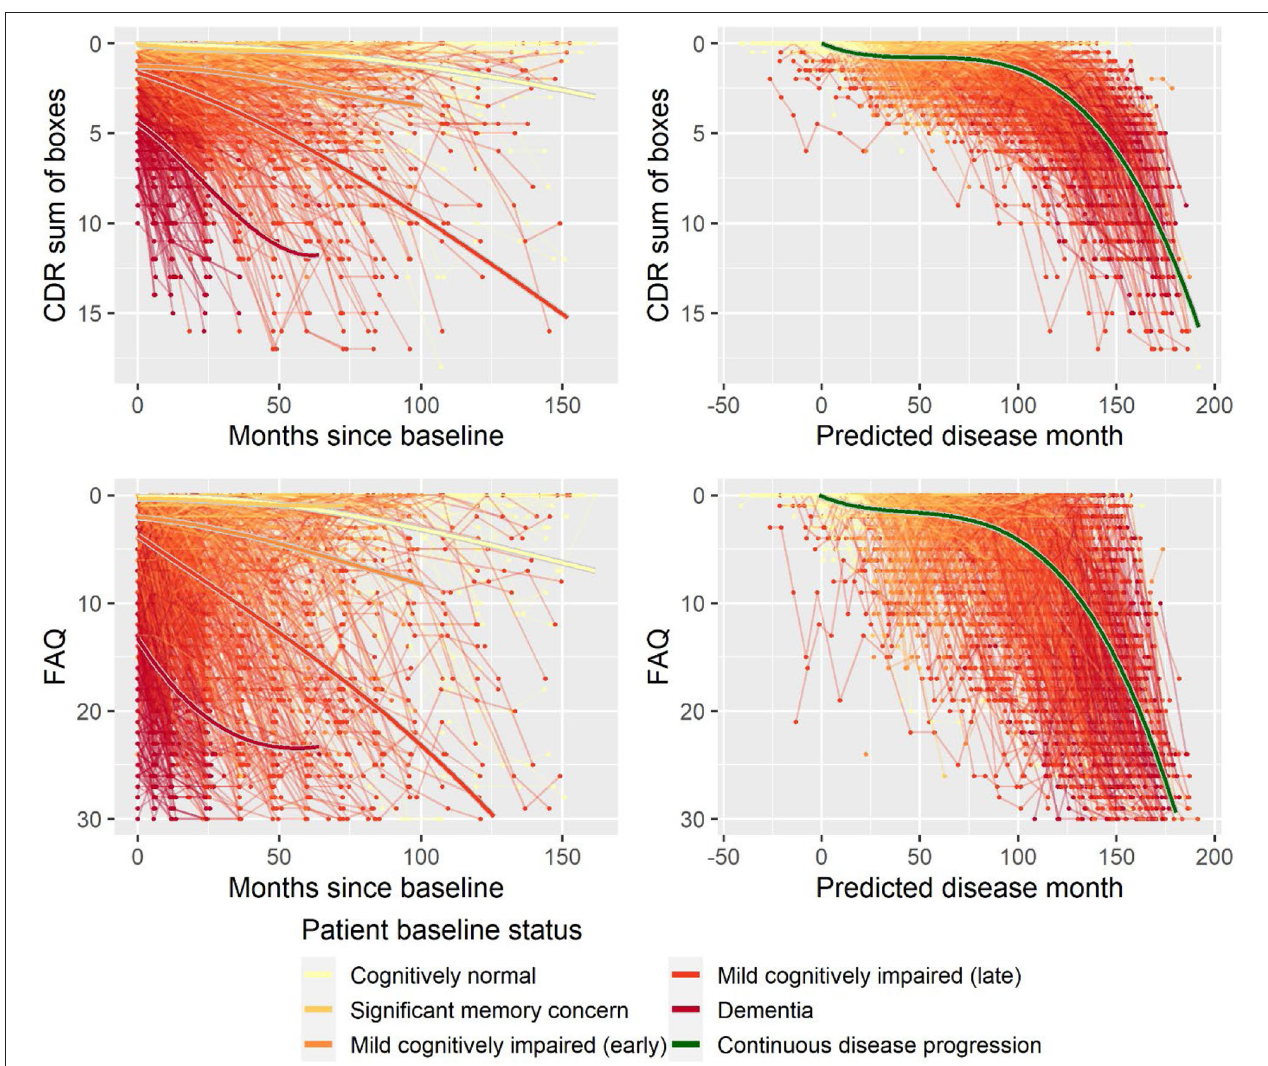
FIGURE 3 | Data and estimated biomarker trajectories for CDR sum of boxes and FAQ. Left column shows results when allowing different trajectories for the five baseline groups; right column shows the results when requiring a single trajectory over predicted disease